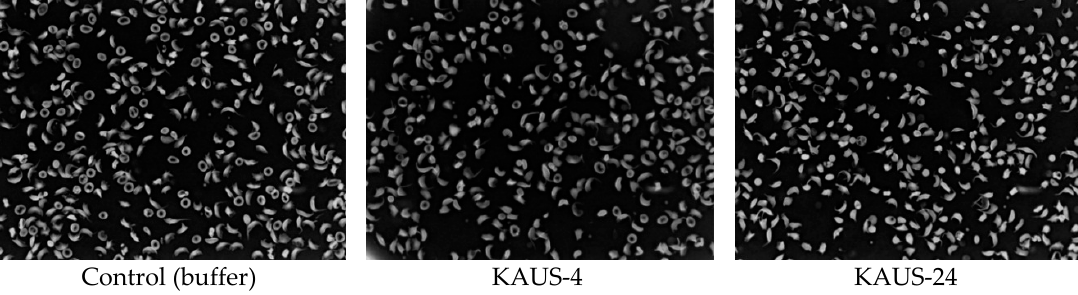
Figure 3. RBC morphological antisickling results of compounds KAUS-4 and KAUS-24. Note that clofibrate and KAUS-23 showed similar prosickling effect as KAUS-24.